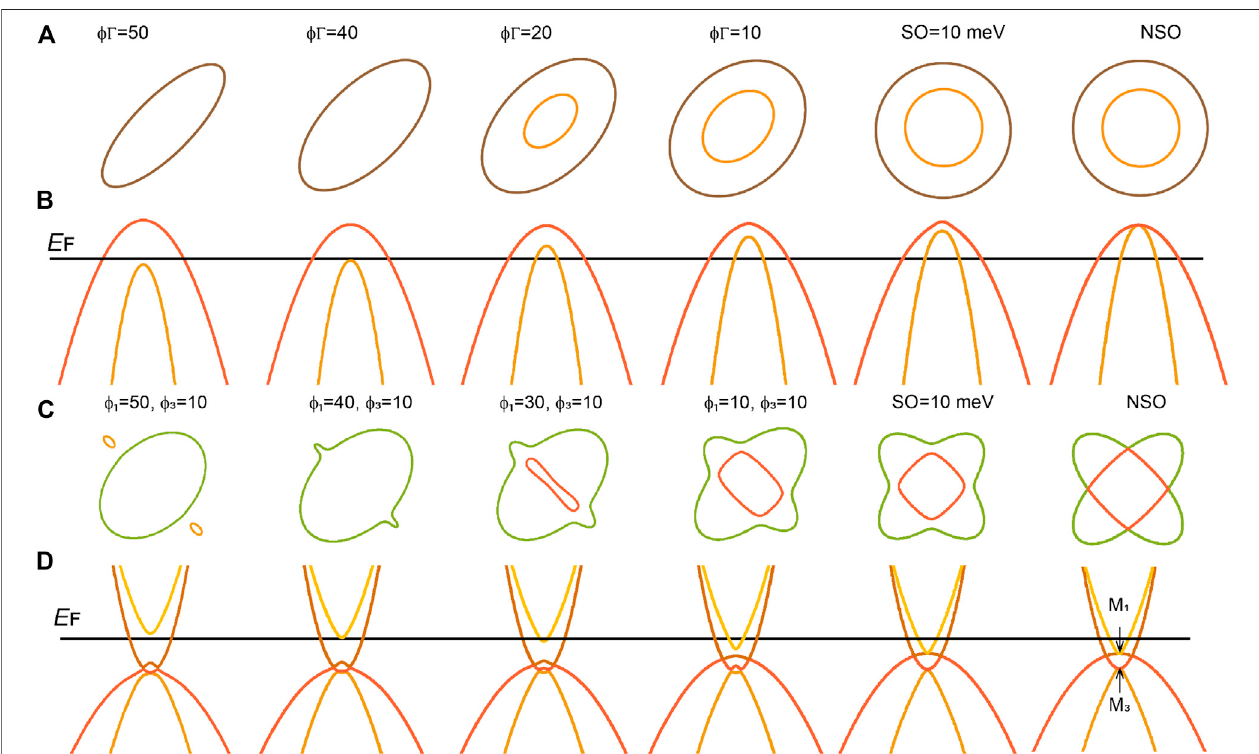
FIGURE 3 | Simulations of the effect of nematicity on the ARPES data. Simulations of the Fermi surface maps and band dispersions in a nematic and tetragonal phase, as described in detail in Refs. 76, 77. This model parameters are adjusted to match the experimental data for the tetragonal x (cid:2) 0.18 in Figures 2B,C and the spin-orbit coupling is considered as being 10 meV. The starting values used in simulations are ϵ 1 (cid:2) − 16, ϵ 3 (cid:2) − 35, m 1 (cid:2) 0.05, m 3 (cid:2) 4 × 10 − 4 , a 1 (cid:2) 964, a 3 (cid:2) − 2,862, v (cid:2) − 327, p 1 (cid:2) − 2,589, p 3 (cid:2) − 589. The simulations on the right side assume the absence of spin-orbit coupling. The orbital order induced affects the electron and (cid:3) holes band dispersion in different way. (A) At the Γ point the band splitting is determined both by the spin-orbit coupling and nematicity, giving a band splitting of (cid:1)(cid:1)(cid:1)(cid:1)(cid:1)(cid:1)(cid:1)(cid:1) Δ 2 + ϕ 2 , and the hole pockets become elongated in (B) . One of the inner hole pocket is pushed below the Fermi level. (C) At the M point the effect of nematicity is Γ SO in fl uenced by the anisotropy of the on-site energies of the d xz ( ϕ 1 ) and d yz orbitals, anisotropic d xy hopping ( ϕ 3 ) as well as the spin-orbit coupling [76] and the electron pocketschangesshapesigni fi cantlyin (D) .Thein-planemapsillustratetherepresentationexpectedforasingledomainsample.Inrealexperiments,thesuperpositionof two different domains rotated by 90 ° could